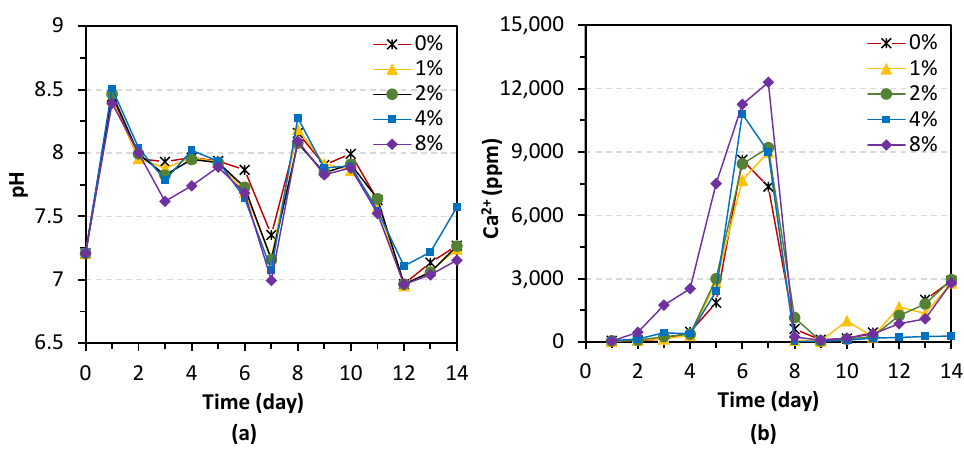
Figure 5. Process monitoring of ( a ) pH and ( b ) concentration of calcium ions during MICP treatment.